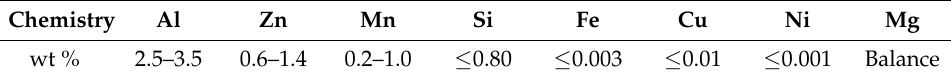
Table 1. Chemical composition of magnesium alloy